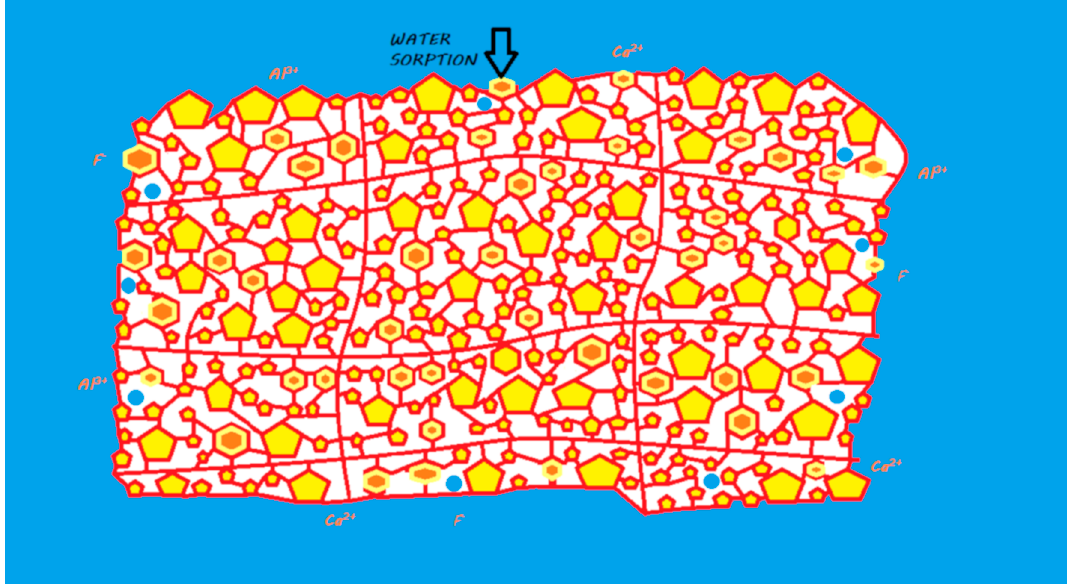
Figure 14. Diagram of ion release from a giomer once it is in contact with the oral environment. When the material is light cured, a resin polymerization reaction is initiated, and monomers can copolymerize with other monomers, silanated S-PRG fillers, and unreactive fillers. No acid–base reaction occurs in the setting reaction of the material. When placed in a moist environment (i.e., oral environment), water sorption occurs, and S-PRG fillers are able to release calcium, aluminum, and fluoride ions. These ions do not participate in the setting mechanism of the material.